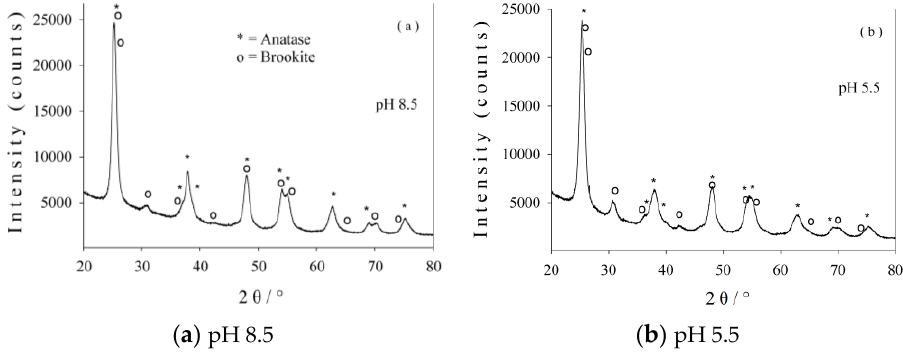
Figure 1. X-ray diffraction (XRD) patterns of photocatalyst 1 ( a ) and photocatalyst 2 ( b ). Table 1. Phase content and crystallite size of hydrothermally-synthesized photocatalysts.